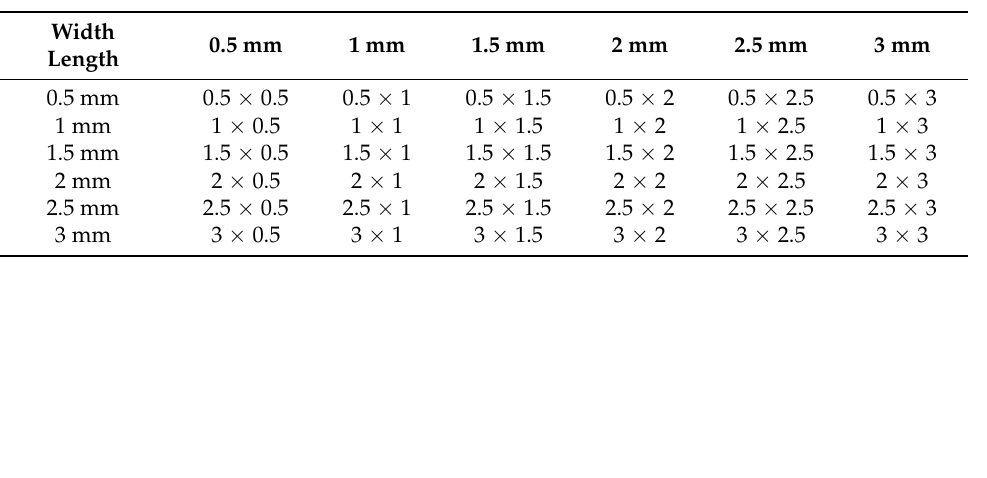
Table 2. Setting of contact area in fracture model: the same contact area and different cross-sections.